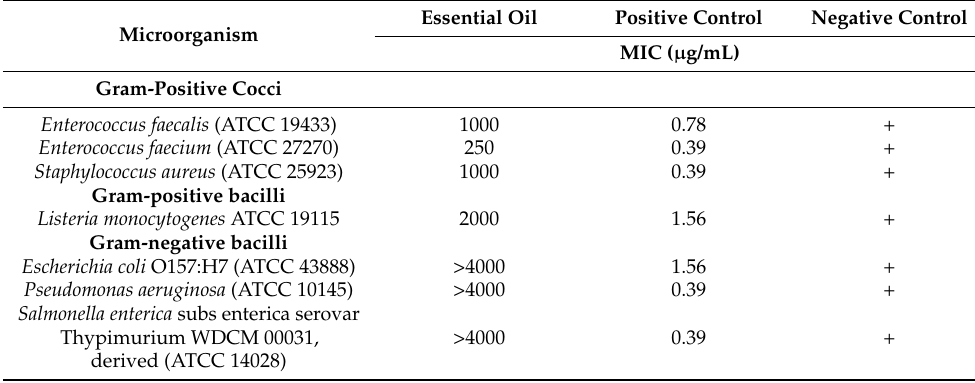
Table 4. Antibacterial activity of essential oil from Bixa orellana